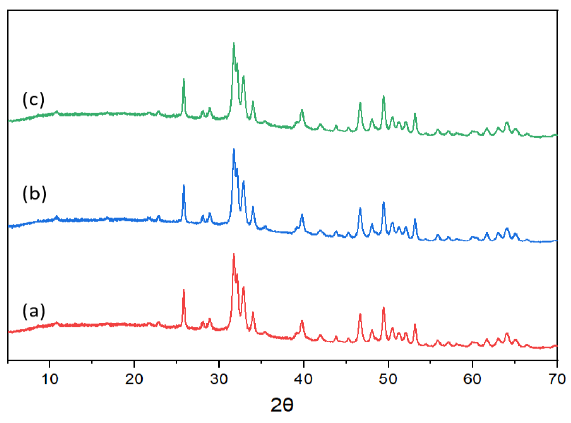
Figure 5. XRD patterns of ( a ) HAp-Et-1, ( b ) HAp-W-1, and ( c ) HAp-Et-Cal-1.